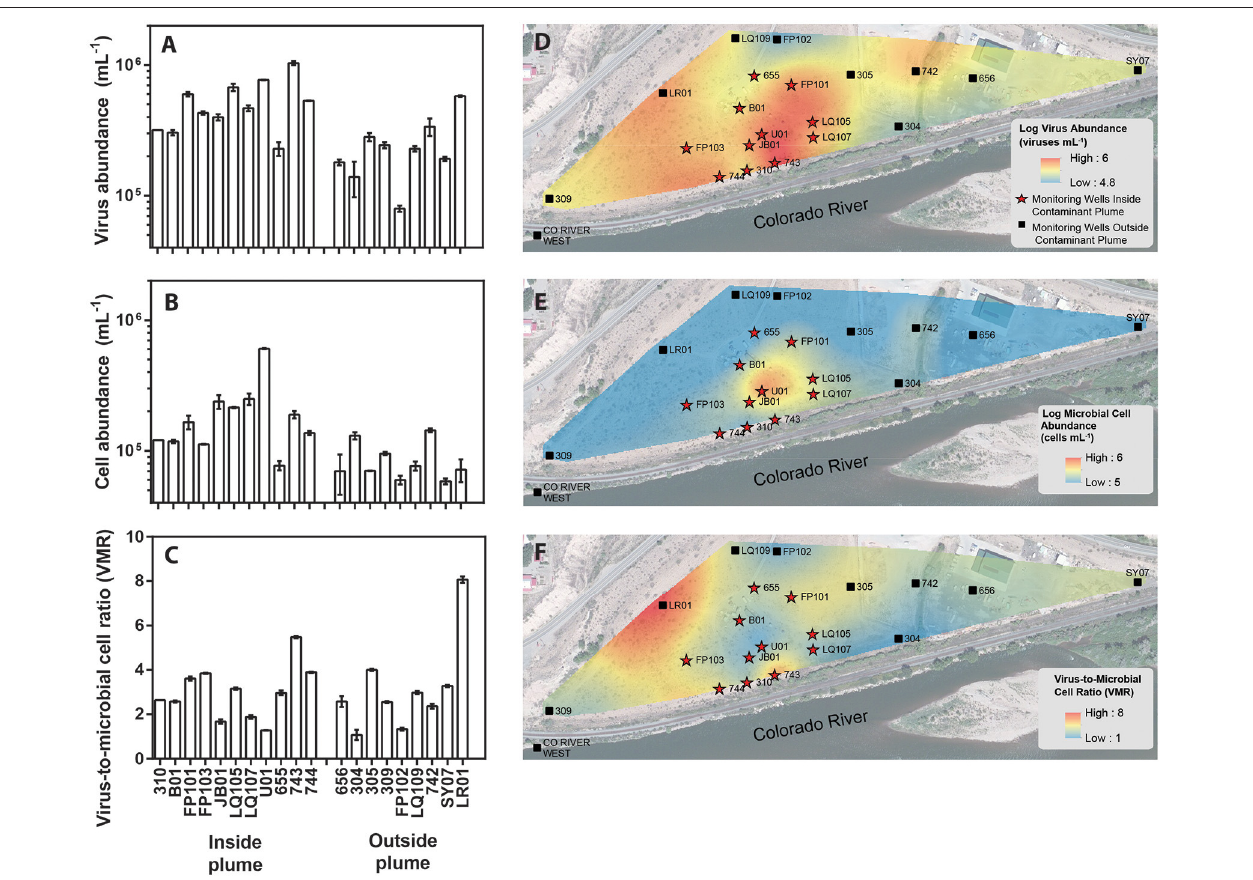
FIGURE 1 | Location of monitoring wells within a uranium contaminated alluvial aquifer located 0.3 miles east of Rifle, Colorado (USA) and adjoining the Colorado River (Well 309 39.52842, − 107.774426 and Well SY07 39.529335, − 107.770864). Monitoring wells located inside the contaminant plume are denoted with red stars whereas monitoring wells located outside of the contaminant plume are denoted as black boxes. Groundwater virus abundance (A), cell abundance (B), and virus-to-microbial cell ratio (VMR) (C) data collected from monitoring wells across the alluvial aquifer. Error bars denoted standard error of measure for duplicate samples. Spatial interpolation of groundwater viruses (D) , cells (E) , and virus-to-microbial cell ratio (F) data collected from monitoring wells in the alluvial aquifer depicting spatial distribution. Color gradient from high (red) to low (blue) denotes interpolated